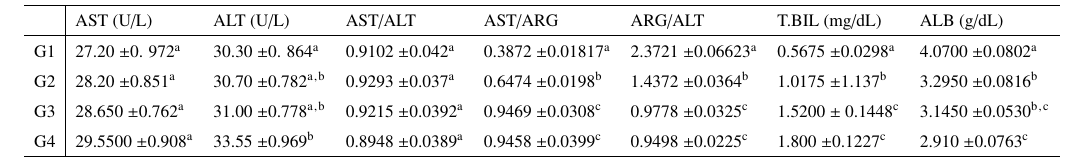
Table 1. Comparison between ALT, AST, AST / ALT, AST / ARG, ARG / ALT, T.BIL and ALB levels in di ff erent studied groups.